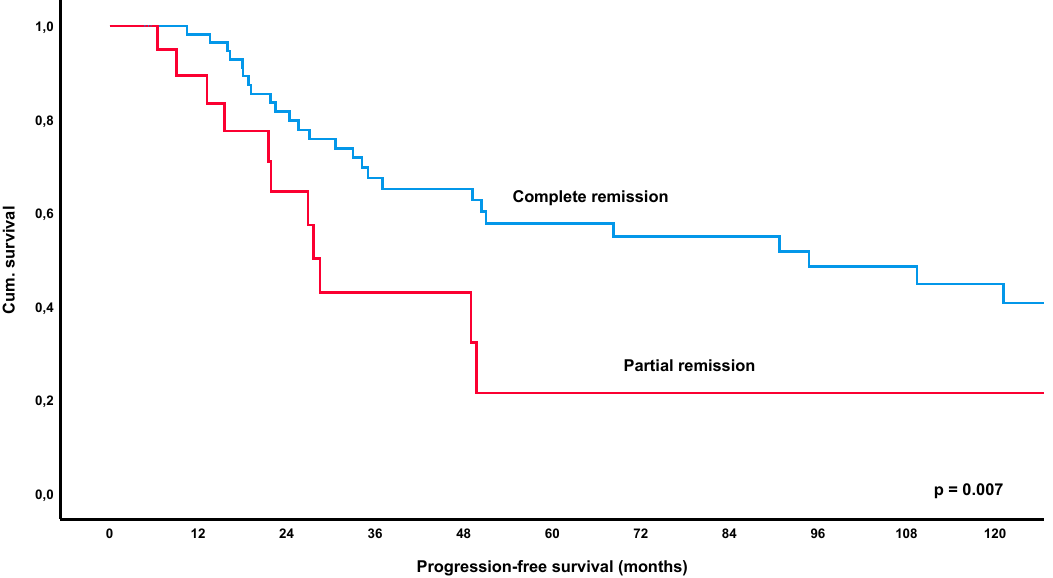
Figure 2. Kaplan-Meier curve for progression-free survival following first-line treatment (various modalities), comparing patients with an objective response ( = partial or complete remission) versus stable disease. Abbreviations: CR = complete remission, PR = partial remission.